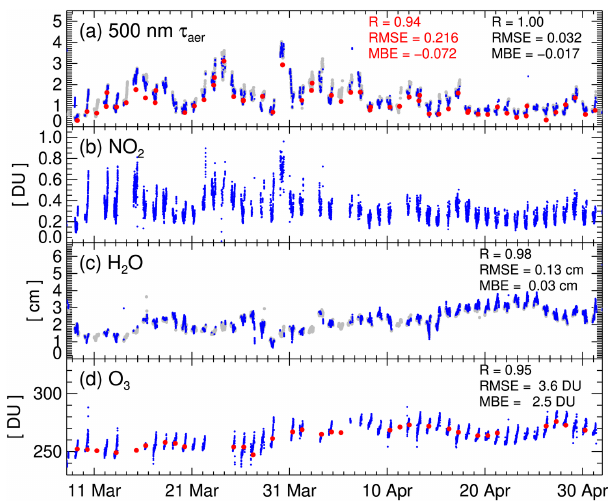
Figure 9. Temporal variations in total columns of (a) aerosol ex- tinction at 500nm, (b) nitrogen dioxide, (c) precipitable water va- por, and (d) ozone at Fang, Thailand, in 2019. The blue circles are from SMART–s retrievals, and the gray circles in panels (a) and (c) show those from AERONET. In panel (a) , the red cir- cles indicate aerosol optical thickness at 550nm from VIIRS Deep Blue (DB), while those in panel (d) depict total column ozone re- trievals from OMI (TOMS version 8.5). The correlation coefficient ( R ), root mean squared error (RMSE), and mean bias error (MBE) in panels (a) , (c) , and (d) are between collocated SMART–s and AERONET/OMI data in black, and those in red in panel (a) are between SMART–s and VIIRS DB